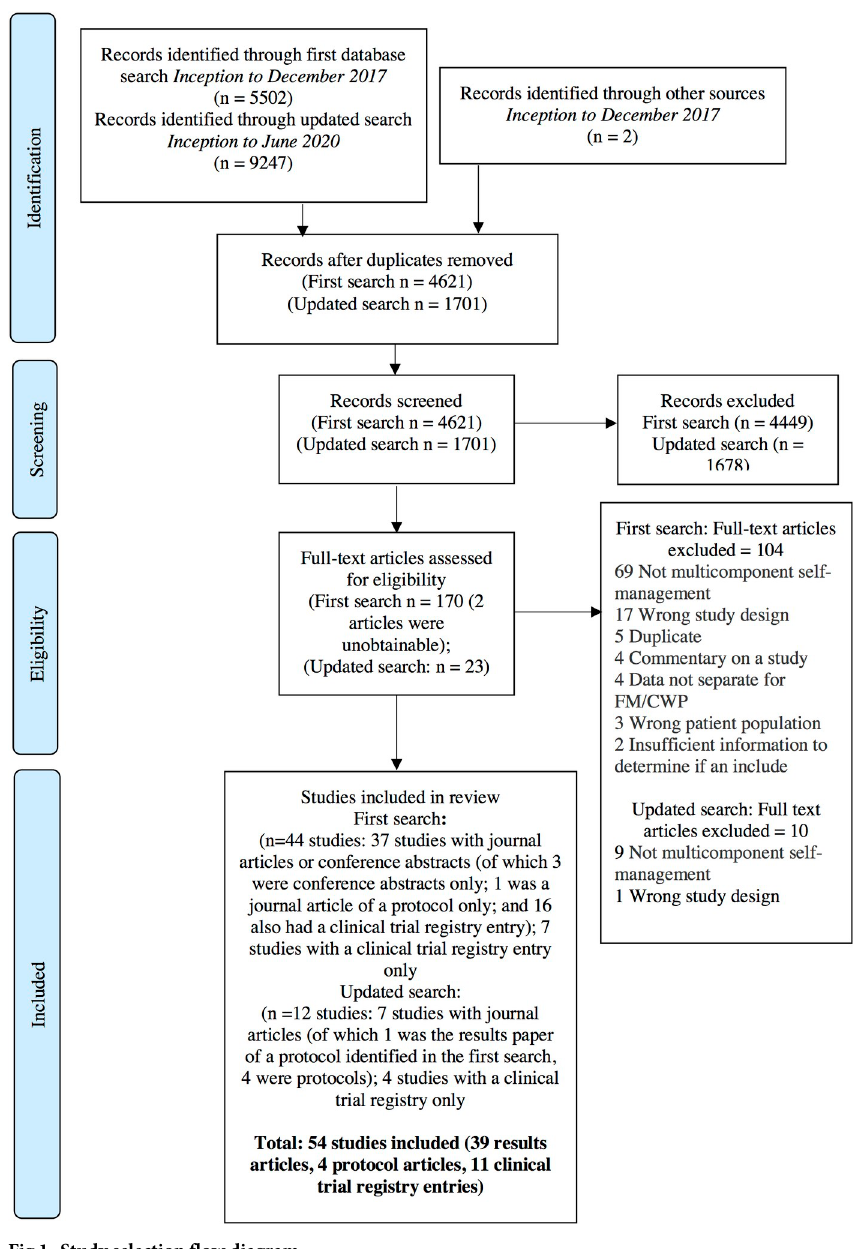
Fig 1. Study selection flow